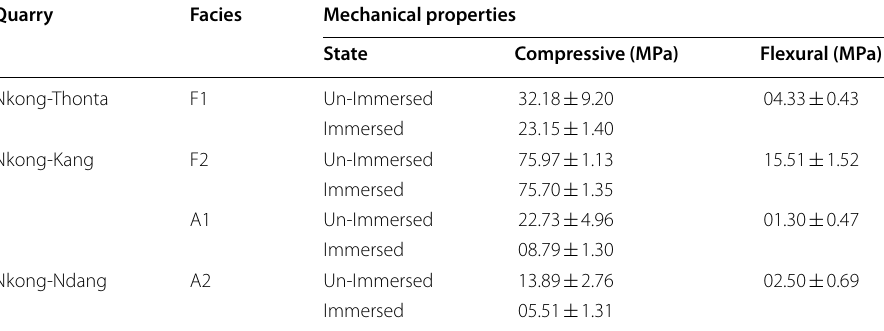
Number of samples (Nbr)